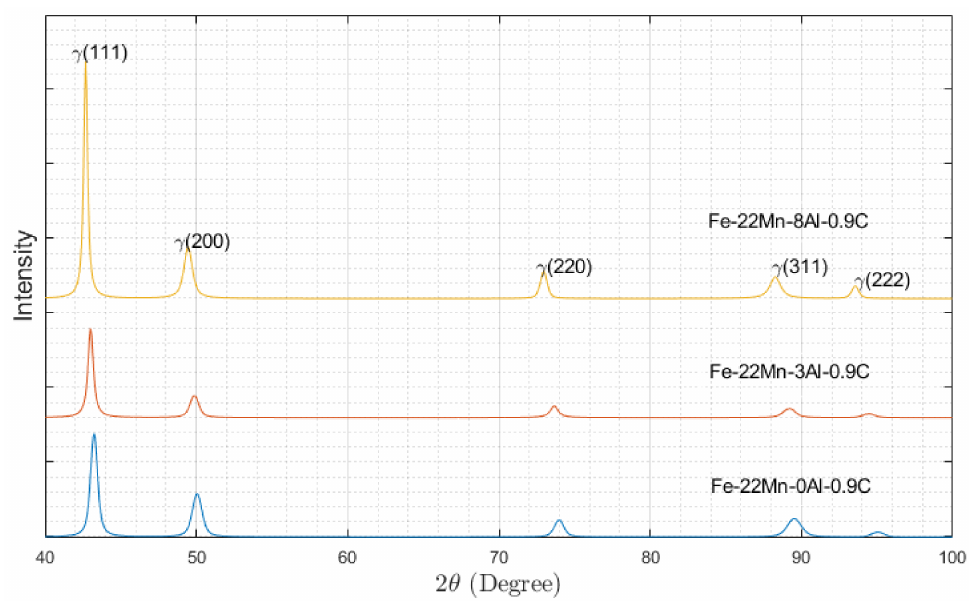
Figure 6. Effect of the variation in the elastic constants C 11 and C 12 for limit values of C 44 on the SFE for Hadfield steel.